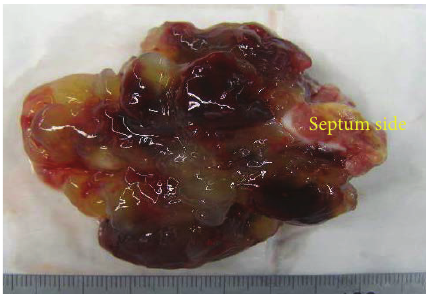
Figure 3: Gross pathology. The excised myxoma measured 7 × 6 × 4 cm. There was a pedicle on the septal side and the tip was